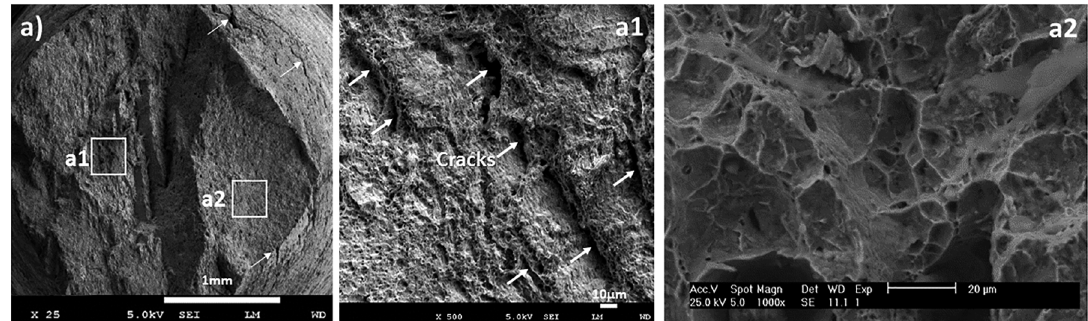
Figure 6. SEM images of the fracture surfaces of X52 pipeline steel tested in NS4 solution with pH of 5 showing the brittle fracture with transgranular